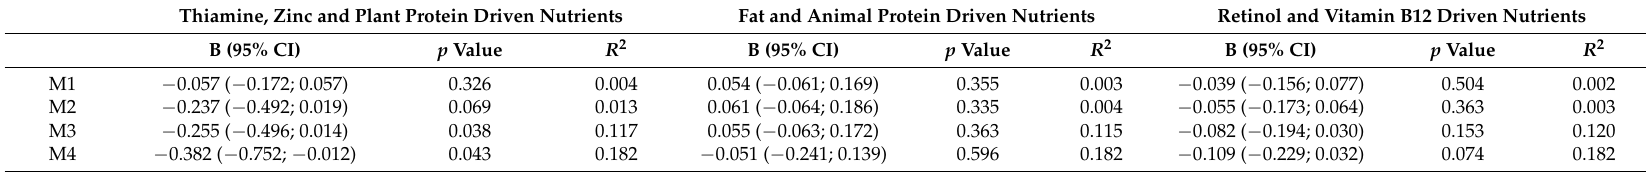
Table 5. Regression coefficients for fasting glucose for 1 SD increase in the derived nutrient pattern scores among rural black South African men. Thiamine, Zinc and Plant Protein Driven Nutrients Fat and Animal Protein Driven Nutrients Retinol and Vitamin B12 Driven Nutrients B (95% CI) p Value R 2